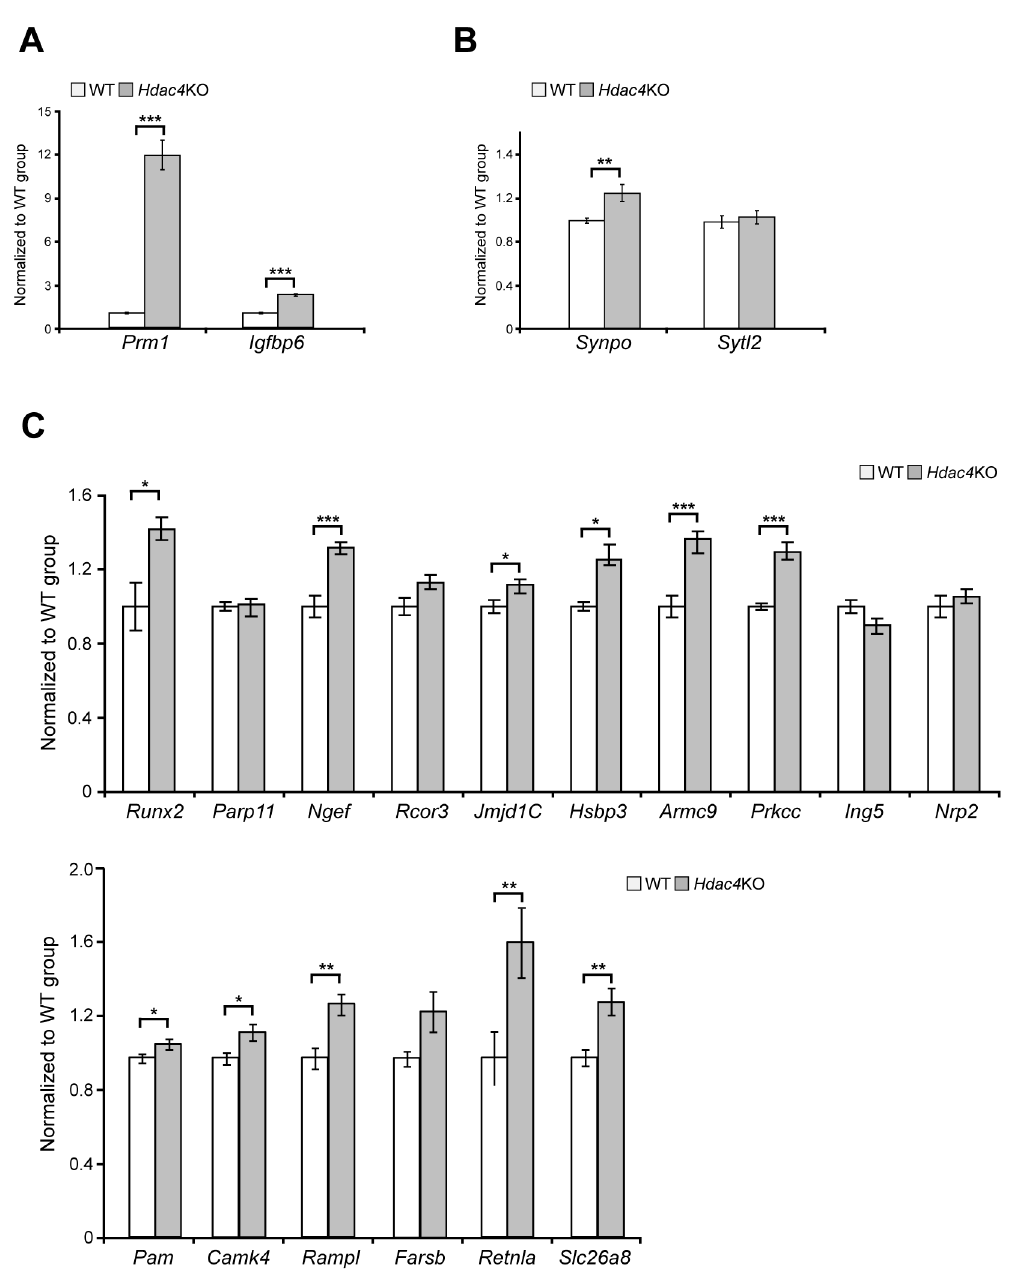
Figure 2. Validation of the genes predicted to be upregulated in Hdac4 knock-out P3 brains. (A) Prm1 (protamine 1) and Igbp6 (insulin-growth factor binding protein 6) transcript levels were significantly upregulated in Hdac4 KO P3 brains by 14-fold and 3-fold respectively. (B) Synpo (Synaptopodin) was modestly upregulated in Hdac4 KO P3 brains whereas Sytl2 (synaptotagmin like 2 protein) was unchanged. (C) Runx2 (runt-related transcription factor 2), Ngef (neuronal guanine nucleotide exchange factor), Jmjd1C (jumonji domain containing 1C), Hsbp3 (heat shock protein 3), Armc9 (armadilo repeat containing protein 9), Prkcc (protein kinase C gamma), Pam (peptidylglycine alpha-amidating monooxygenase), CamkIV (calcium /calmodulin-dependent protein kinase IV), Ramp1 (receptor (calcitonin) activity modifying protein 1), Retnlα (resistin like alpha protein), Slc26α8 (solute carrier family 26, member 8) were modestly upregulated in Hdac4 KO P3 brains whereas Parp11 (poly(ADP-ribose) polymerase member 11), Rcor3 (REST corepresor 3), Ing5 (inhibitor of growth family 5) Nrp2 (neuropilin 2) and Farsb (phenylalanyl-tRNA synthetase, beta subunit) were unchanged. All mRNA expression levels were assessed by Taqman qPCR and presented as a relative expression ratio to the geometric mean of three housekeeping genes Atp5b , Canx , Rpl13α . Error bars are S.E.M (n>7). * p <0.05, ** p <0.01, *** p <0.001.